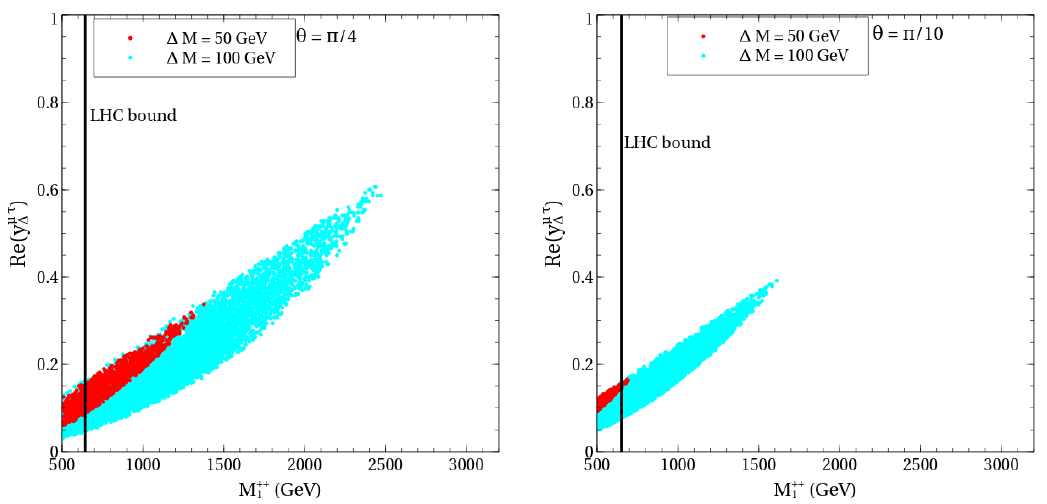
Figure 5 . The allowed parameter space maintaining (cid:1) a (cid:22) within its 2 (cid:27) range and BR (cid:28) ! (cid:22) (cid:22)ee within the quoted limit in the M ++ Re( y (cid:22)(cid:28) ) plane for (cid:18) = (cid:25) (left) and (cid:25) (right). A normal neutrino 1 (cid:0) (cid:1) 4 10 mass hierarchy is assumed. The color coding is explained in the legends. The region left to the black line is disallowed by the dilepton searches at the LHC.